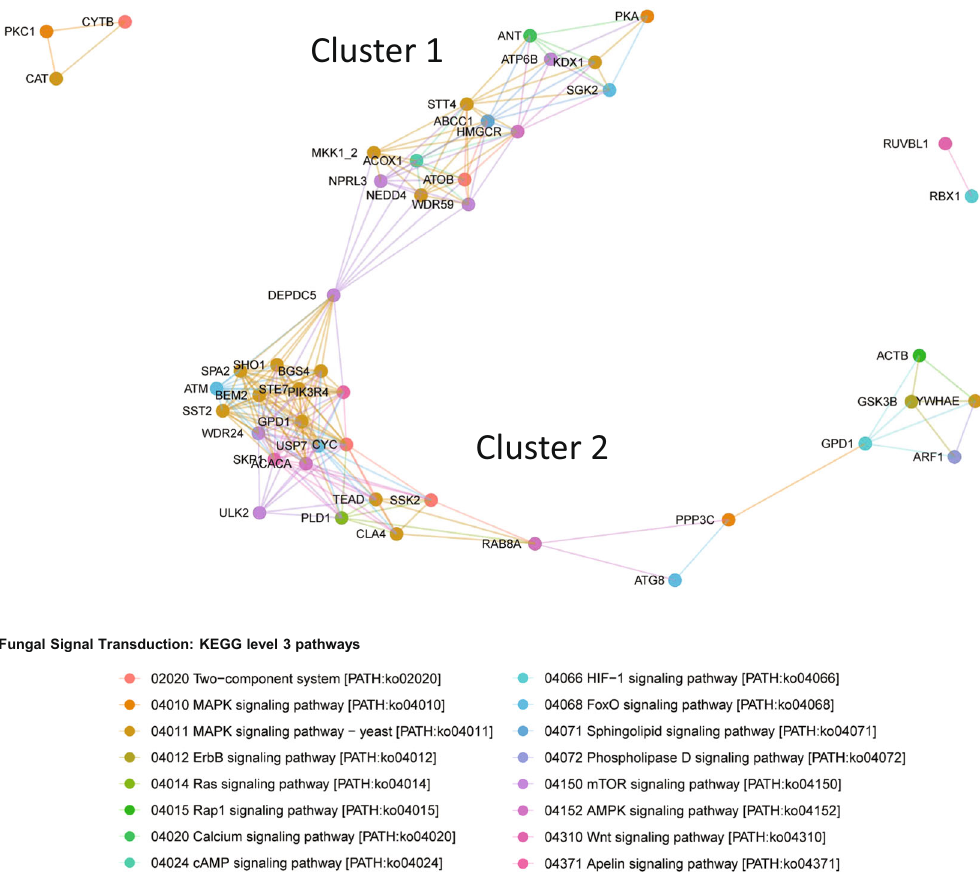
Fig. 4 Gene expression network of the fungal KEGG level 2 signal transduction pathway using Bray – Curtis dissimilarity. Each circle represents a KEGG Orthology (KO) gene and lines connect similar expression patterns across the three samples. Only KOs associated with signal transduction pathways within the fungal community are